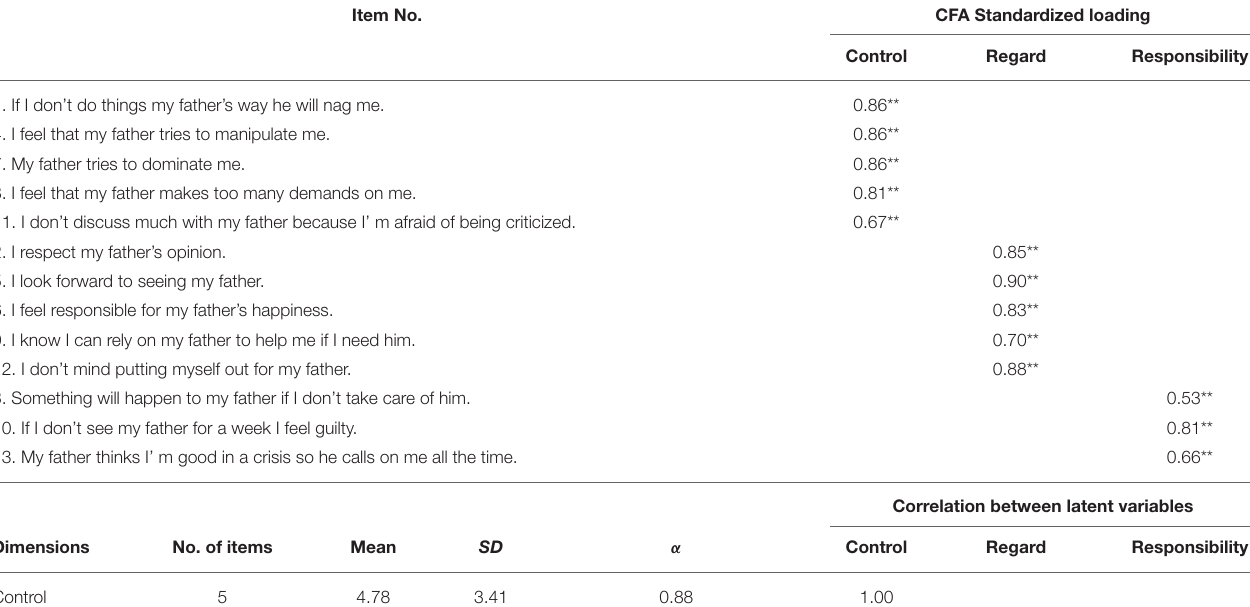
TABLE 6 | Confirmatory factor analysis and factor correlations based on responses to the PACQ for father. Item